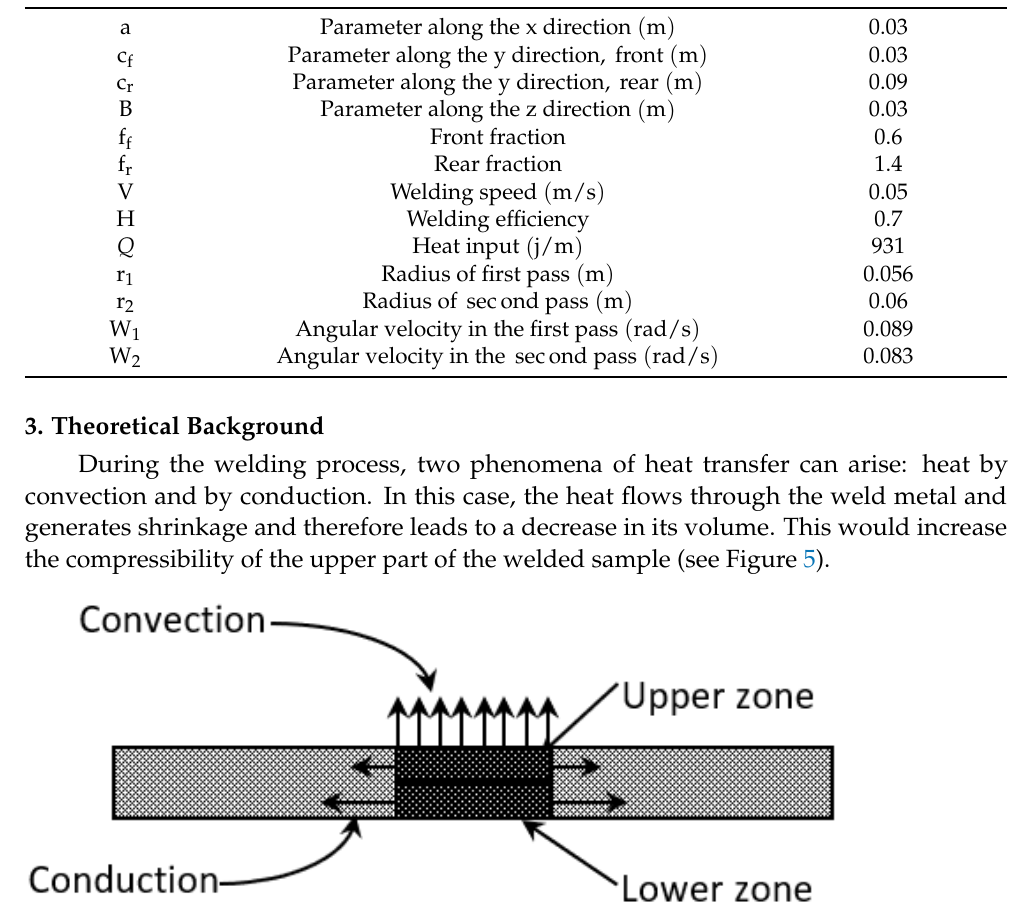
Table 1. Welding parameters and heat source parameters for the finite element model.